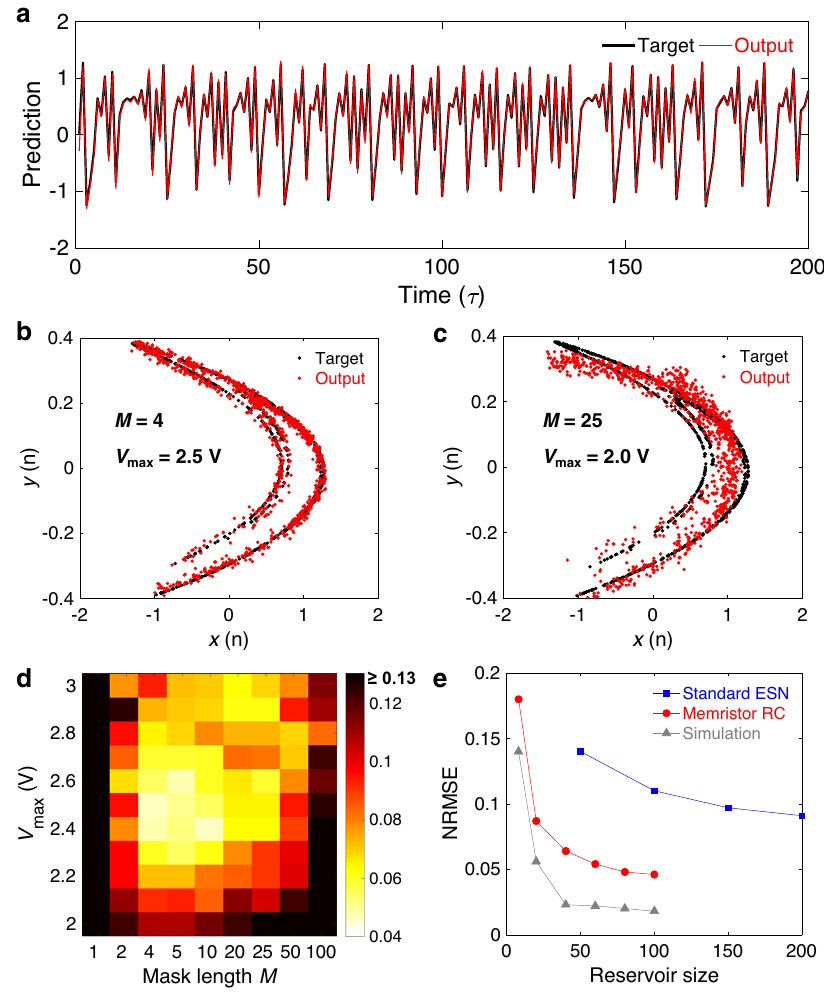
Fig. 4 Demonstration of Hénon map prediction. a The predicted results obtained by the memristor-based parallel RC system, where the black line represents the ideal target and the red line represents the experimental output from the RC system. Test parameters are set to be M = 4, N = 25, V max = 2.5 V and V min = − 0.8 V. b , c 2-D display of the predicted results under different test parameters, where the M and V max in b and c are 4, 2.5 V and 25, 2.0 V, respectively. V min and the total reservoir size ( M × N ) remain unchanged at − 0.8 V and 100, respectively. d The prediction error varies with the two test parameters M (1 – 100) and V max (2.0 – 3.0 V), where the color bar represents the NRMSE (values >0.13 are shown in black in the fi gure). V min and M × N remain unchanged. e The NRMSE changes with the reservoir size in different RC systems including the standard ESN (results in ref. 40 ), memristor- based parallel RC, and software-simulated one. In both experiment and simulation, the mask length remains constant at 4, and the total reservoir size is adjusted by changing the number of parallel reservoirs N